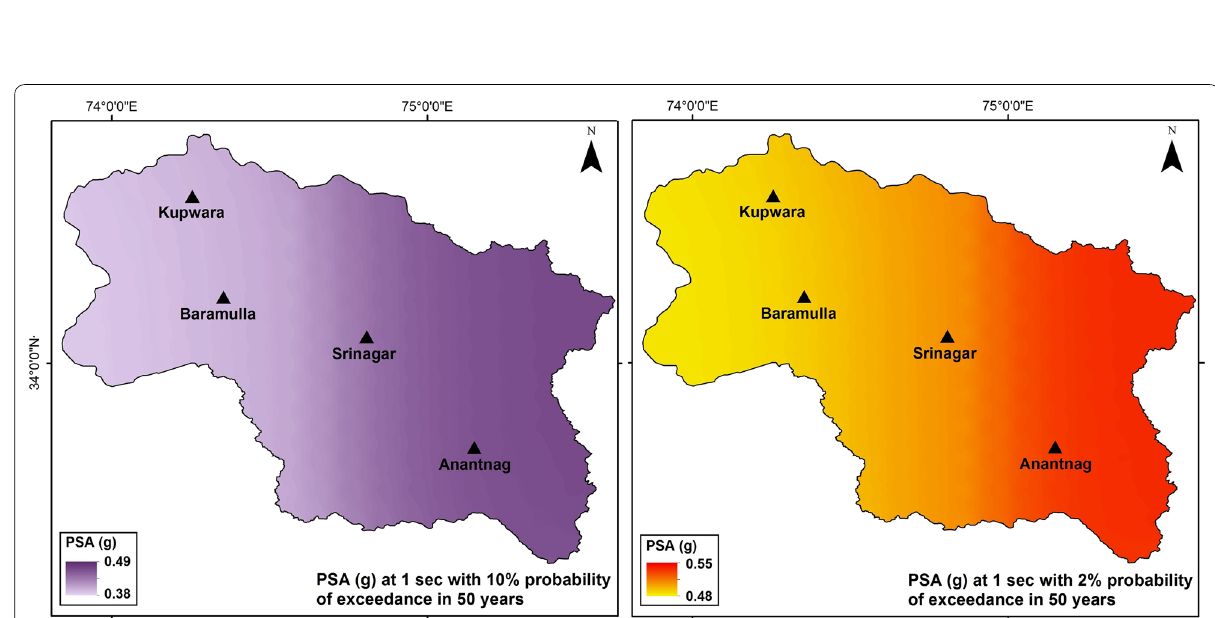
Fig. 8 The seismic hazard maps showing predicted pseudo spectral acceleration (PSA) in g at 1 s (s) with 2% and 10% probability of exceedance within 50 years for engineering bed rock sites. The sources are faults and seismic sources zones are considered sources for this